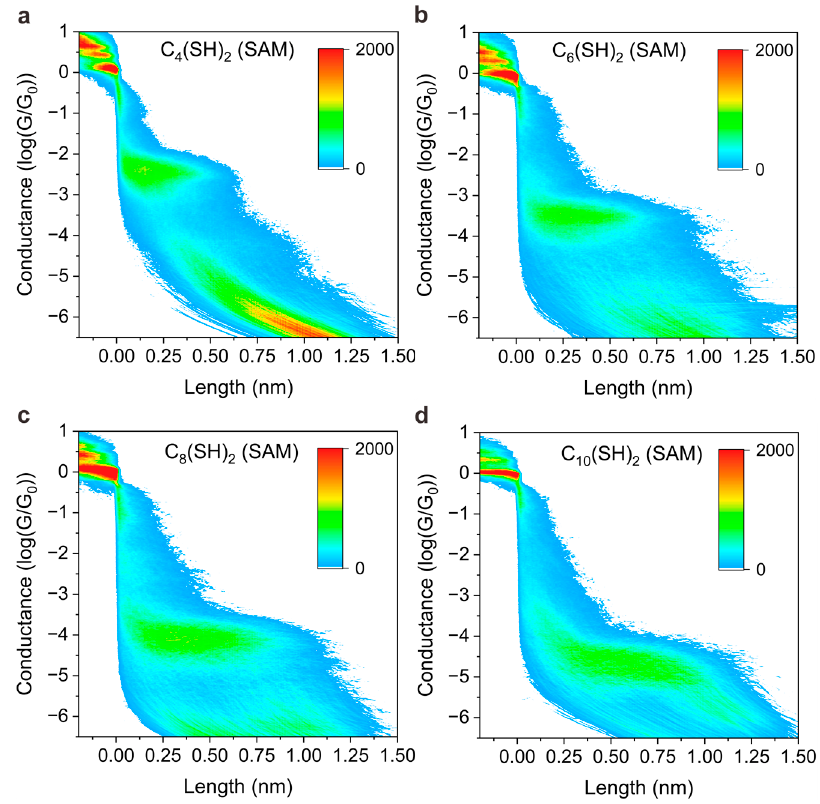
Figure 3. Experimental results of single-molecule conductance measurements with SAM-based junction. The 2D conductance–distance histograms for C 4 (SH) 2 ( a ), C 6 (SH) 2 ( b ), C 8 (SH) 2 ( c ), and C 10 (SH) 2 ( d ) were measured without laser